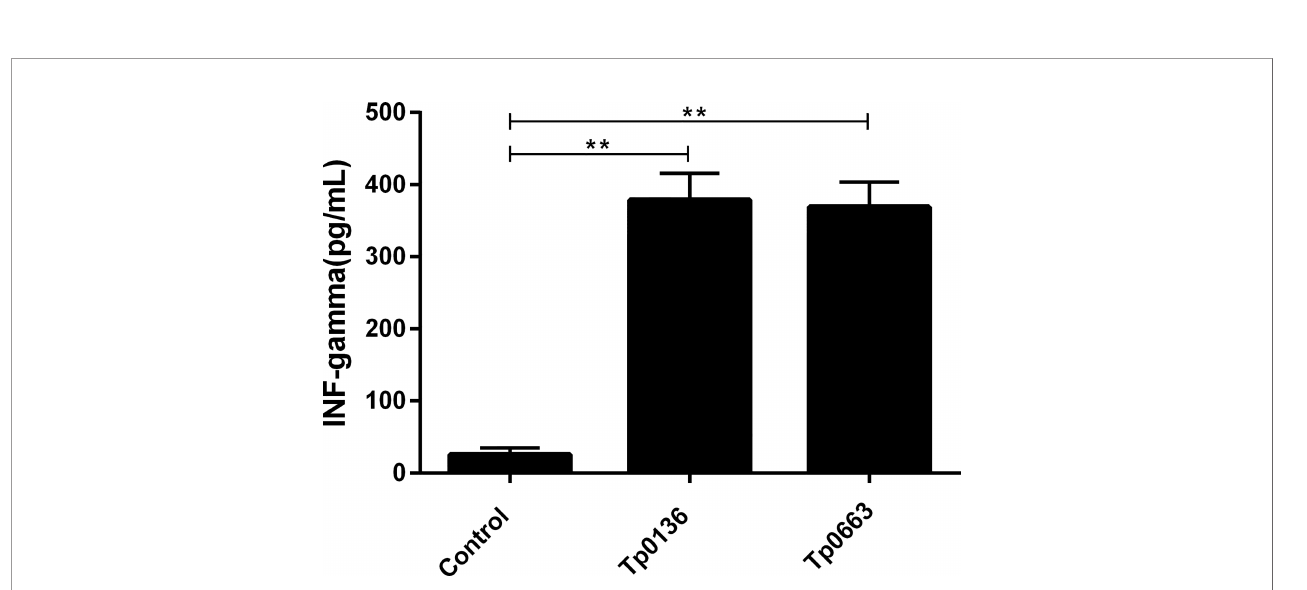
FIGURE 2 | Production of IFN- g in rabbits immunized with recombinant Tp0136 or Tp0663 protein. Following the fi nal immunization, blood was collected from each rabbits ’ ear vein. The IFN- g level in the blood was evaluated by ELISA according to the manufacturer ’ s instructions. The results are expressed as the mean ± SD from three individual rabbits in each group. Each experiment was performed in three independent experiments (** P < 0.01).